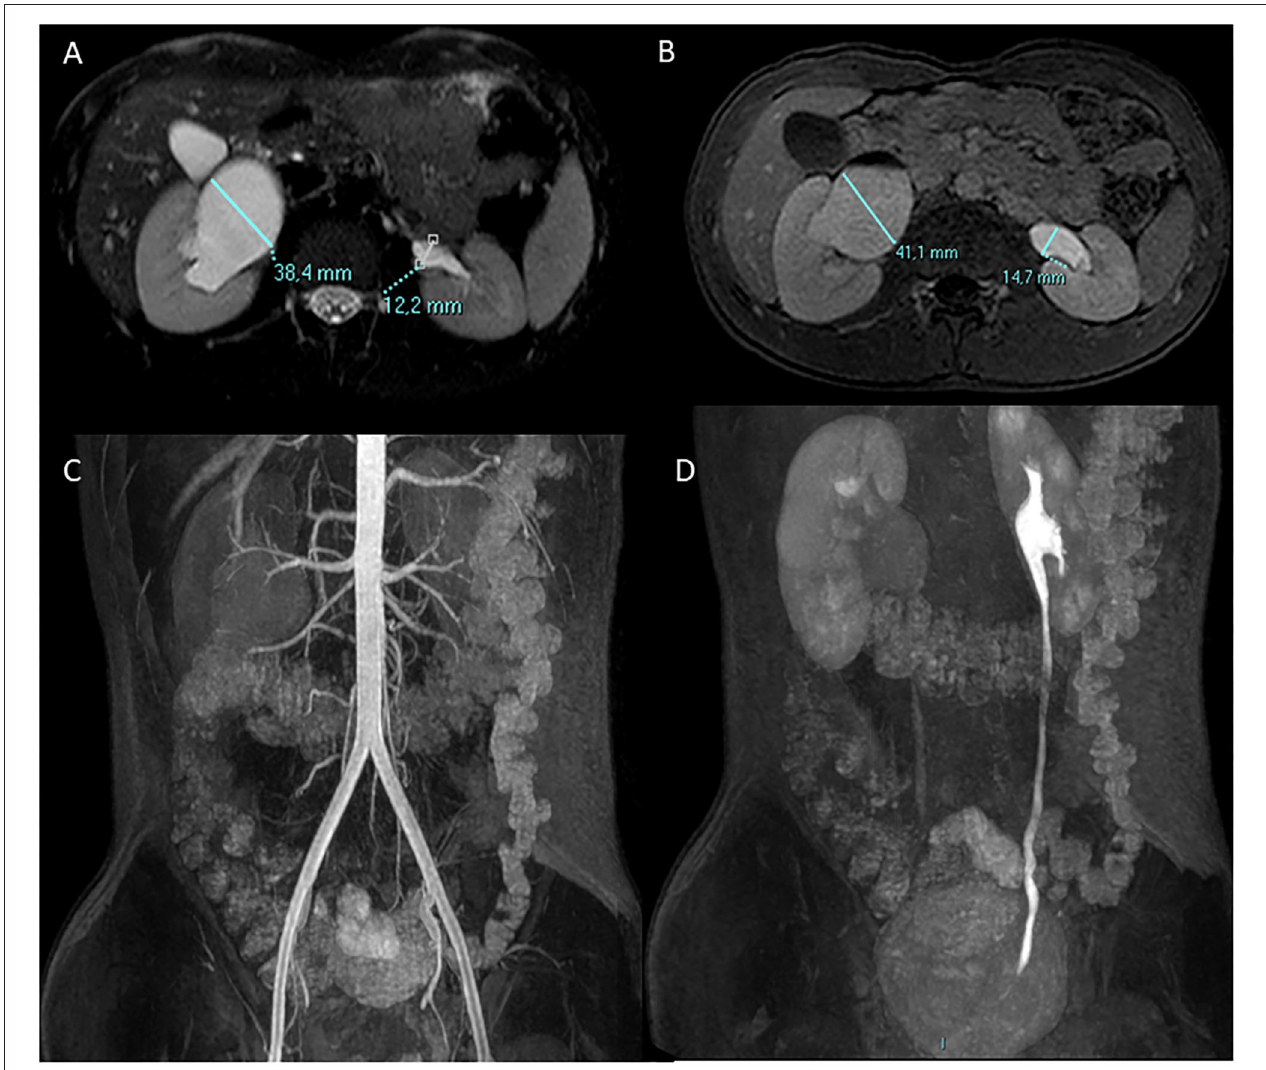
FIGURE 2 | A 13-year-old boy with right UPJO due to a crossing lower pole accessory renal artery. Antero-posterior diameter of the pelvis is measured in the axial plane pre (A) and post (B) Furosemide injection. Coronal angiographic gradient echo 3D sequence post contrast medium injection (C) shows the right lower pole accessory renal artery which crosses the homolateral UPJO, the urographic phase is delayed in comparison with the contralateral side as shown in the coronal 3D gradient echo urographic sequence (D)